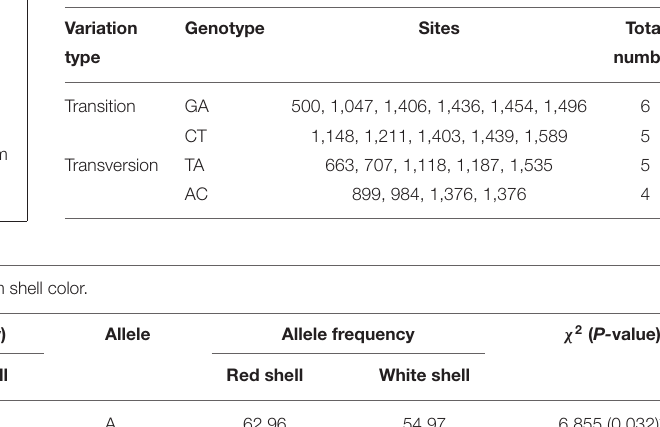
TABLE 3 | Variation type of the SNPs of Mm-BCDO2 gene.